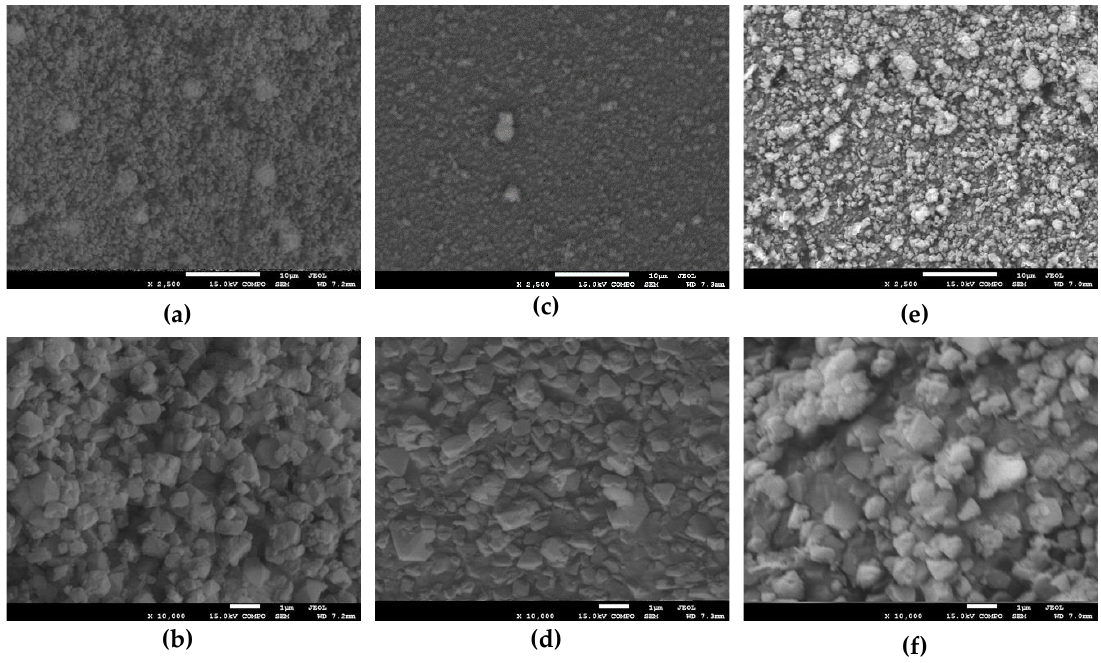
Figure 2. Scanning electron microscopy (SEM) images of the prepared samples: FAUdes ( a , b ), V 1.0 FAUdes ( c , d ), and V 3.0 FAU ( e , f ).